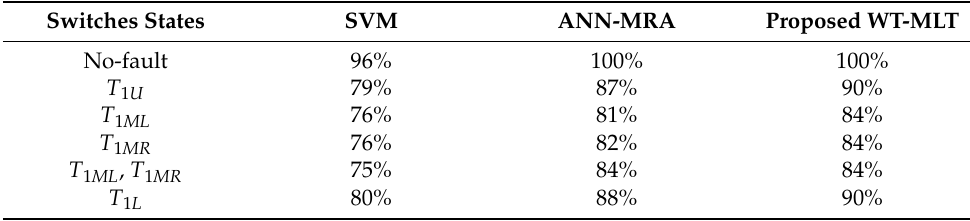
Table 3. Comparison between the proposed and other advanced methods regarding the fault classifi- cation